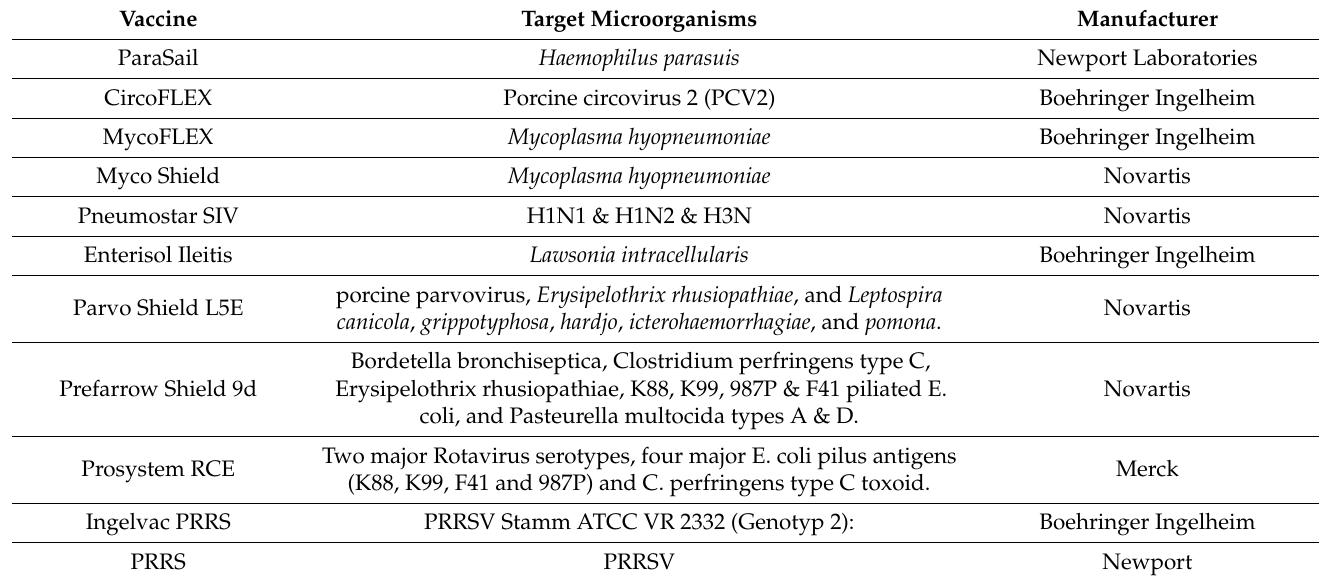
Table 5. Vaccines used in a pig breed generated for islet cell xenotransplantation